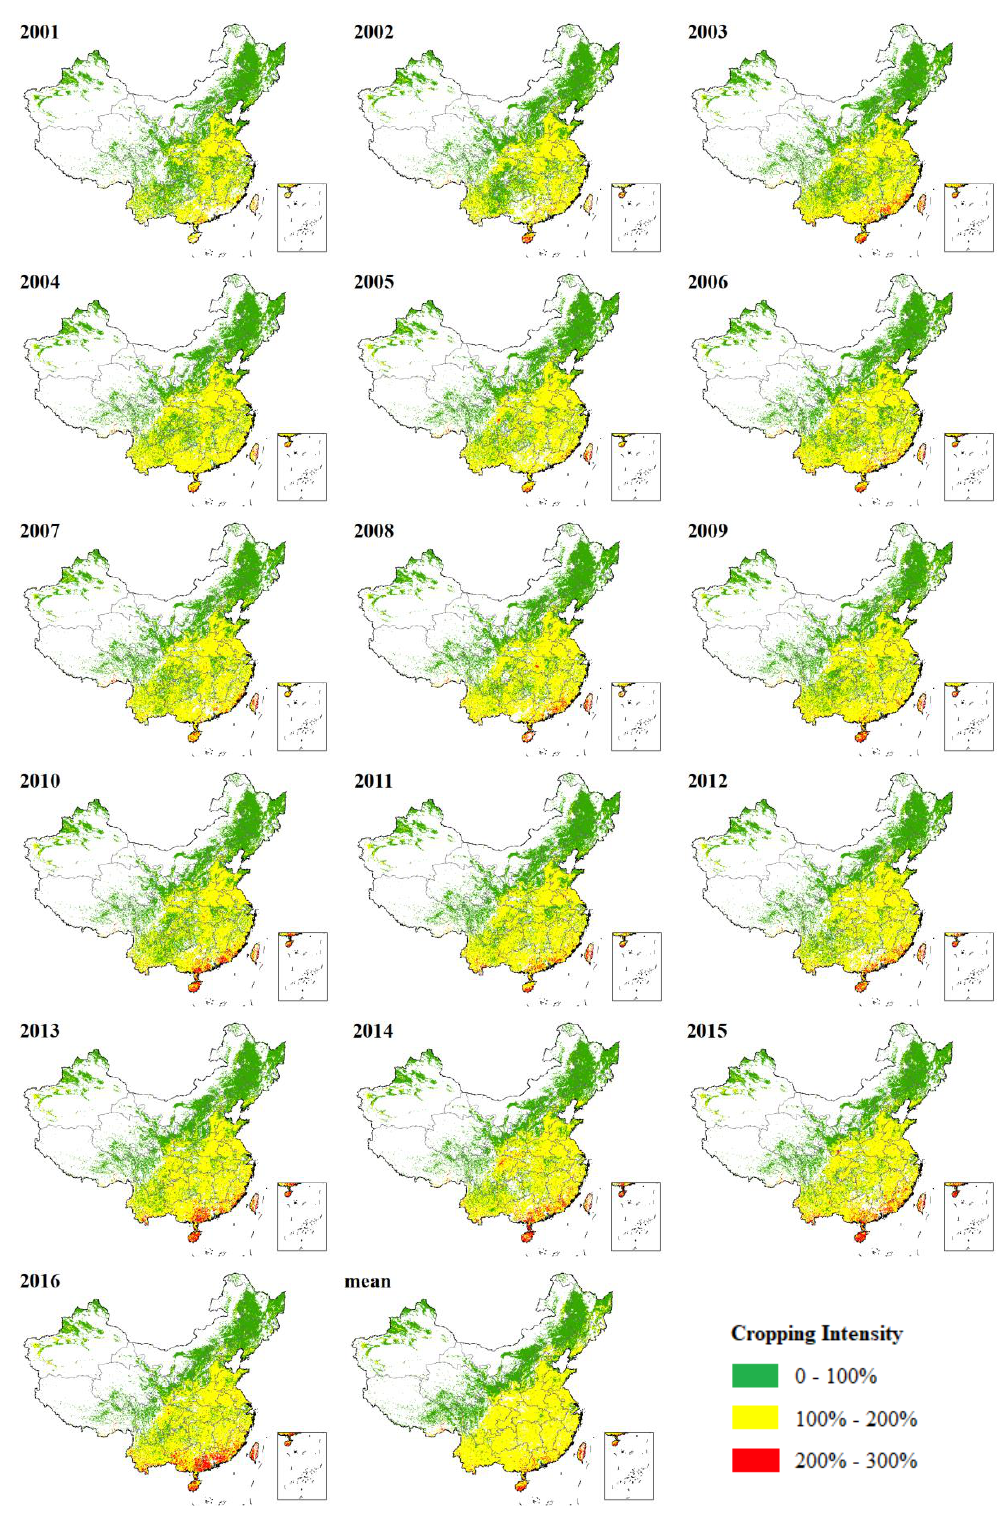
Figure 2. Annual mean cropping intensity maps for each individual year and the sixteen-year mean cropping intensity map in China from 2001 to